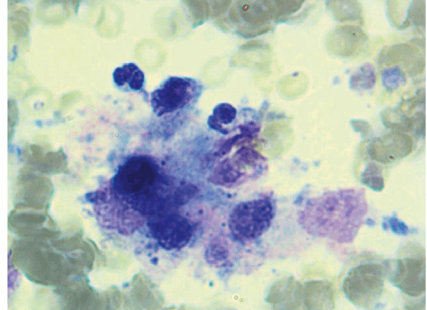
Figure 2: Bone marrow aspiration for case two showing macro- phage activation syndrome